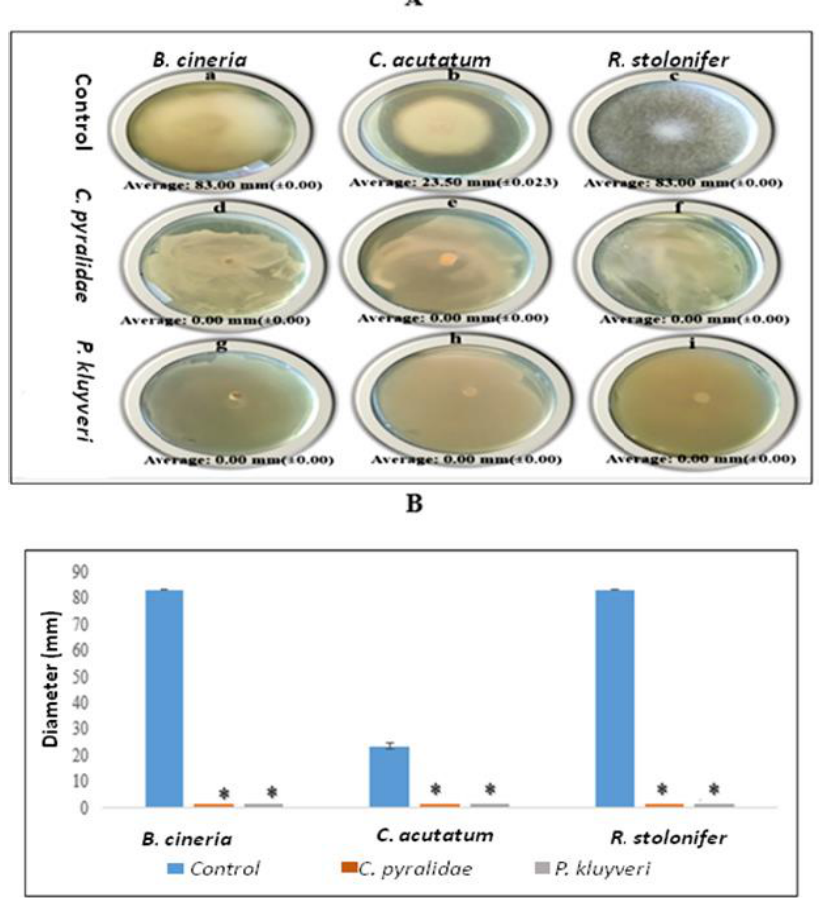
Figure 3. The visual ( A ) and graphical ( B ) representation the antagonistic effect of volatiles produced by C. pyralidae against B. cinerea (A: d), C. acutatum (A: e) and R. stolonifer (A: f), and the antagonistic effects of Pichia kluyveri against the growth of B. cinerea (A: d), C. acutatum (A: e) and R. stolonifer (A: f). The negative controls are displayed as B. cinerea (A: a), C. acutatum (A: b) and R. stolonifera (A: c). Values are averages of three replicates with the standard deviation given brackets. The asterisk (*) indicates values that differ significantly from the control ( p < 0.05).